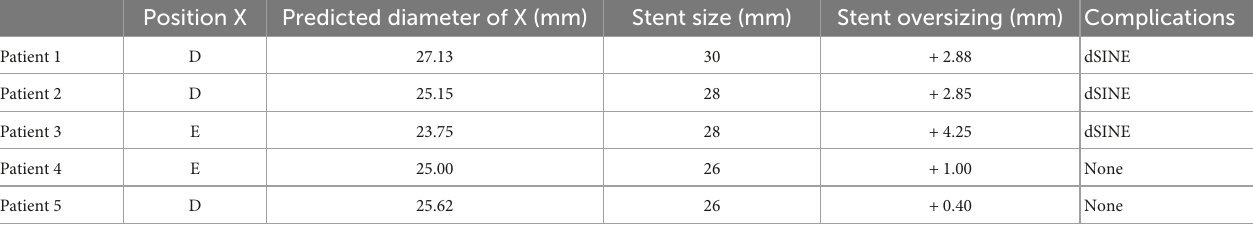
TABLE 3 Validation of TEVAR patients.